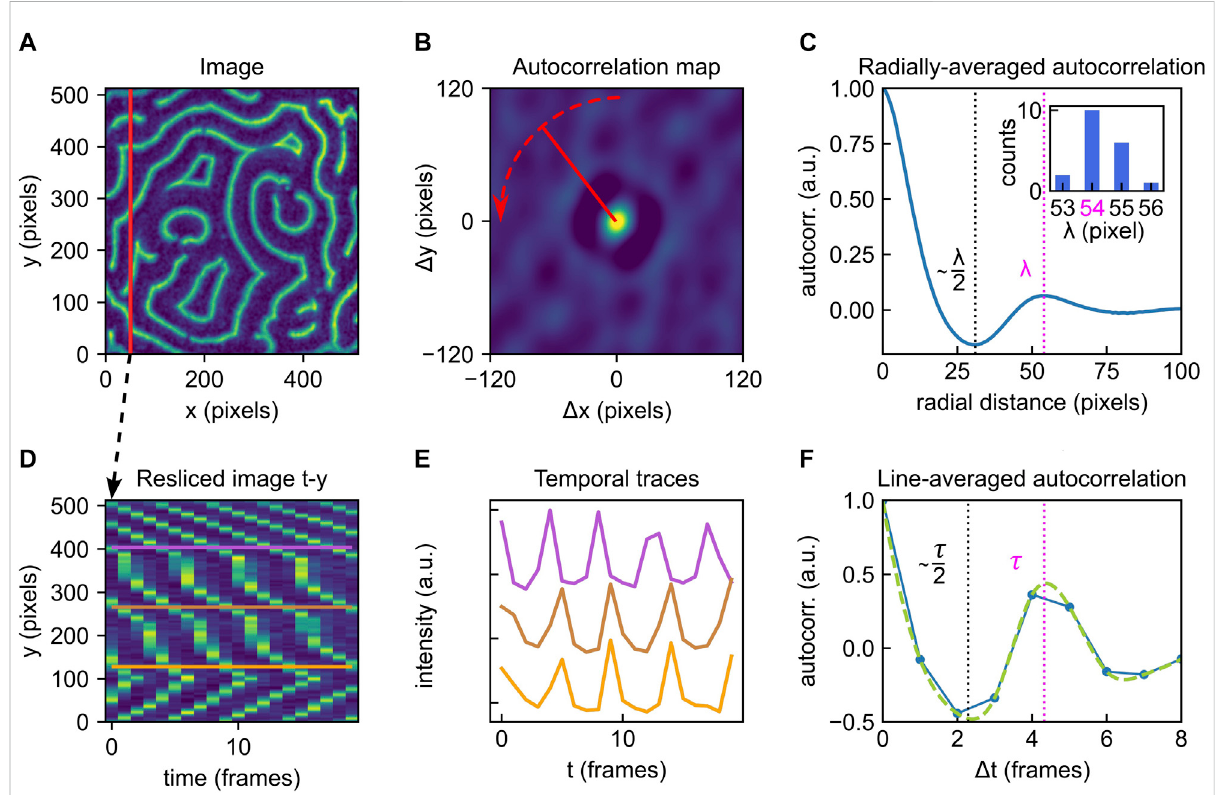
FIGURE 2 Overview of the autocorrelation analysis pipeline to obtain global parameters. (A) Example of a Min protein surface pattern, single frame. Color brightness indicates fl uorescence intensity (a.u.). (B) Autocorrelation map of the frame shown in A. Color brightness indicates intensity. Red dashed lineindicatesradialaveraging. (C) Averagedradialpro fi lefortheautocorrelationmapshowninB.The fi rstmaximumafterthecentralpeakatdistance zero is a measure of the patterns global characteristic wavelength. The identi fi ed wavelength λ is highlighted by the magenta dashed line. The fi rst valley is positioned at approximately λ /2 (black dashed line). Inset: the analysis presented in (A – C) can be performed for all individual frames withinanimagestack.Here,thecollectedresultsfor 20consecutiveframes(imagestackalso representedinFigure1B)areshowninahistogram.A λ of 54 pixels isdeduced. (D) Resliced image for fi xed x ;same as shown in Figure 1D. (E) Selected temporal tracesfor the y -positions indicated in D. All point-traces shown in the kymograph in D will be included in the autocorrelation trace shown in F. (F) Line-averaged autocorrelation trace from point-traces(suchasshowninE)inblue,cubicspline fi tusedforpeak-detectioningreen.The fi rstmaximumafterthecentralpeakat Δ t =0measures the average characteristic oscillation period of the pattern. The identi fi ed global oscillation of τ =4 frames is highlighted by the magenta dashed line. The fi rst valley is positioned approximately at τ /2 (black dashed line). The analysis pipeline illustrated in (D-F) can be performed for multiple slices ( fi xed x or y ) of the image